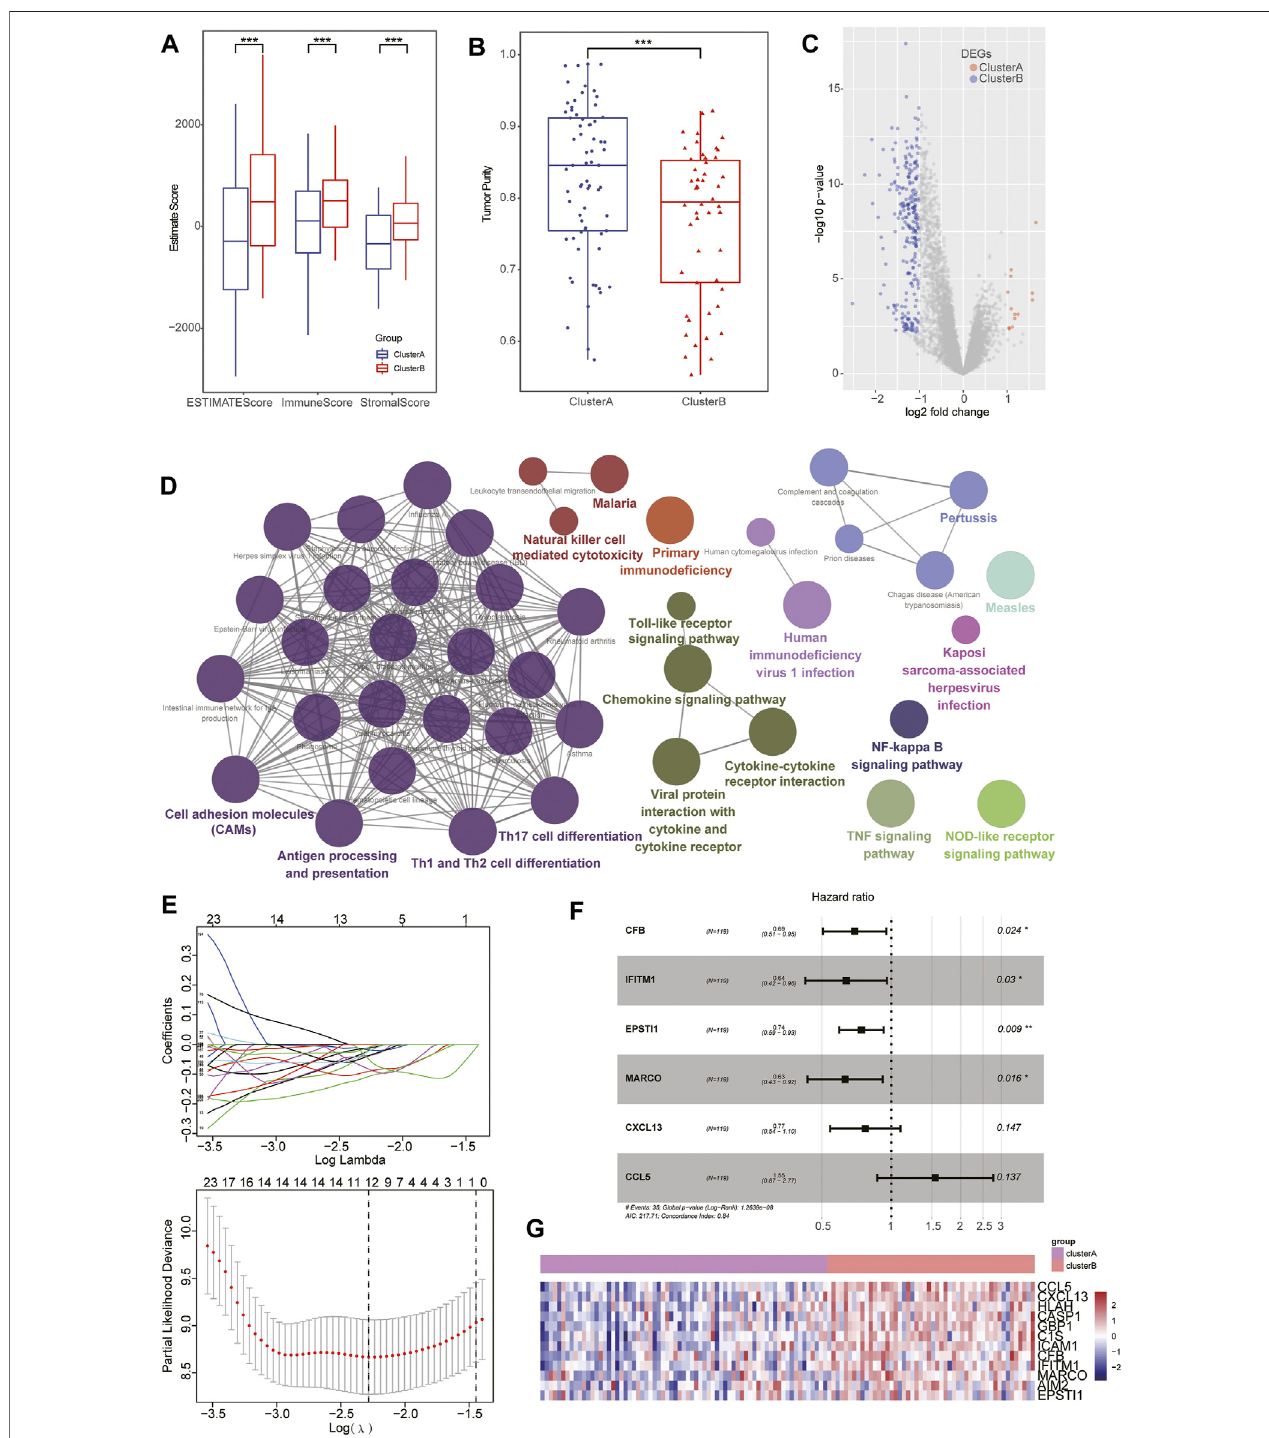
FIGURE 3 | Identi fi cation of DEGs based on pyroptosis-related clusters. (A – B) Box plot showing higher stromal and immune scores with lower tumor purity detected in patients of clusterB than the clusterA group. (C) Volcano plots displaying the up- and downregulated DEGs between two subgroups in TNBC cohorts. (D) Bubble diagram showing the results of KEGG enrichment analysis of the subtypes. (E) LASSO coef fi cient pro fi les of 12 prognostic related genes and 10-times cross- validation for tuning parameter selection in the LASSO model. (F) Forest map displaying the HR and p -value of six hub genes after multivariate Cox regression analysis. (G) Heatmap showing the distinct expression of six hub genes between pyroptosis-related clusters.